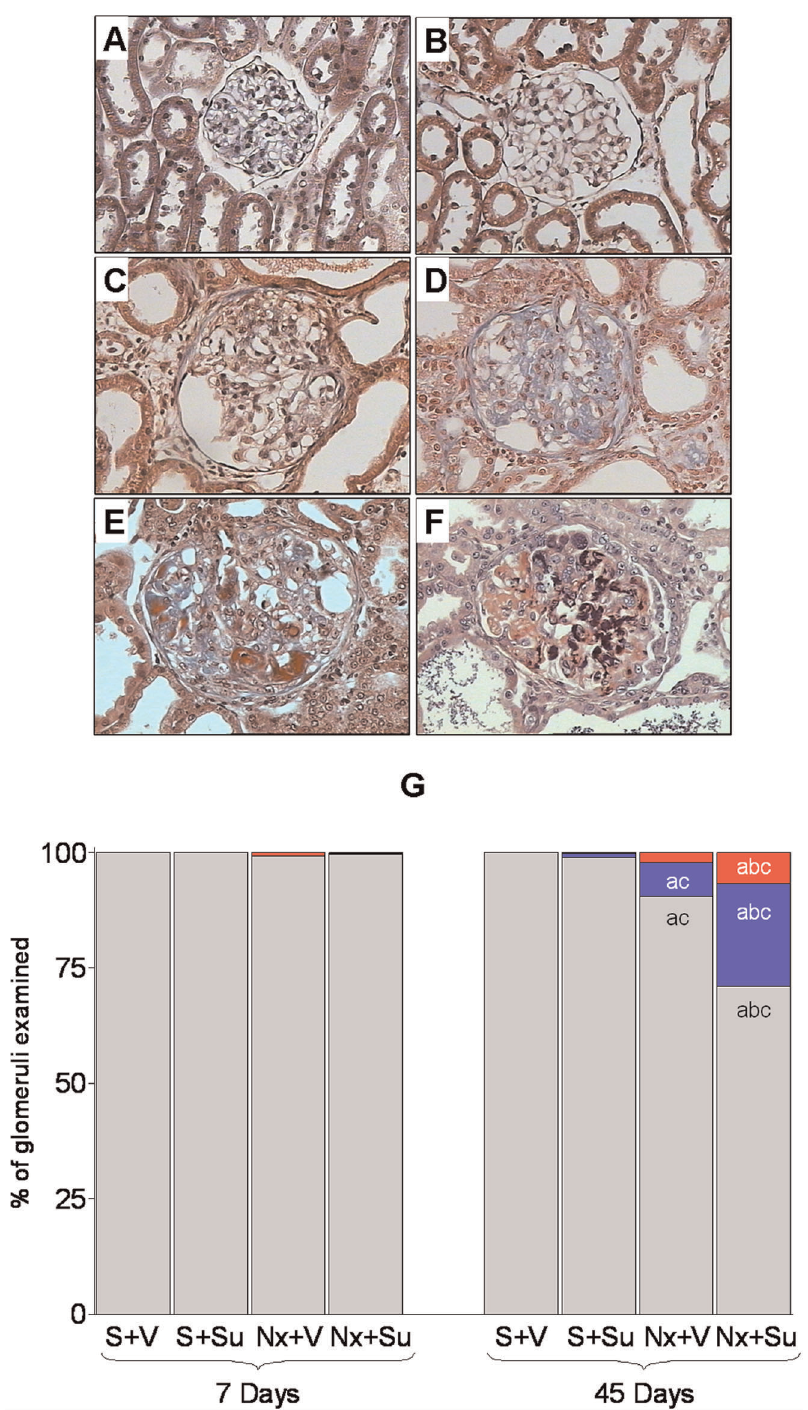
Figure 3. Histologic and histomorphometric analysis of glomerular injury (Masson Trichrome). A) and B) normal glomeruli found in Group S + V and S + Su, respectively; C) and D) representative glomerular sclerotic lesions found in Group Nx + V and Nx + Su. E) glomerular intracapillary microthrombi observed in Group Nx + Su, some of which appear partially organized. F) PTAH staining showing the presence of fibrin (in dark purple) in glomerular capillary lumina of Nx + Su rats. G) distribution of glomerular lesions among ‘‘microthrombi’’ (red) and ‘‘sclerosis’’ (blue). Normal glomeruli are represented in gray. a p , 0.05 vs. respective S; b p , 0.05 vs. respective untreated; c p , 0.05 vs. respective value on Day 7.